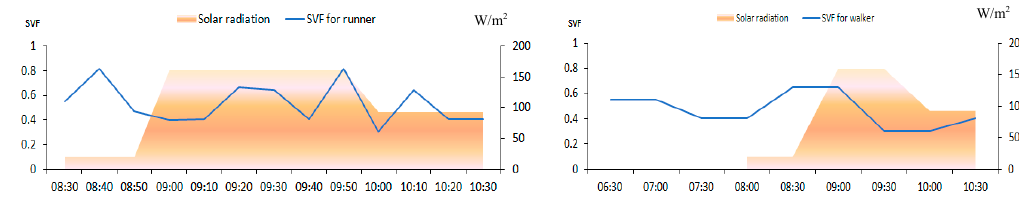
Figure 4. Spring running event route, activity photos, and fisheye photos.